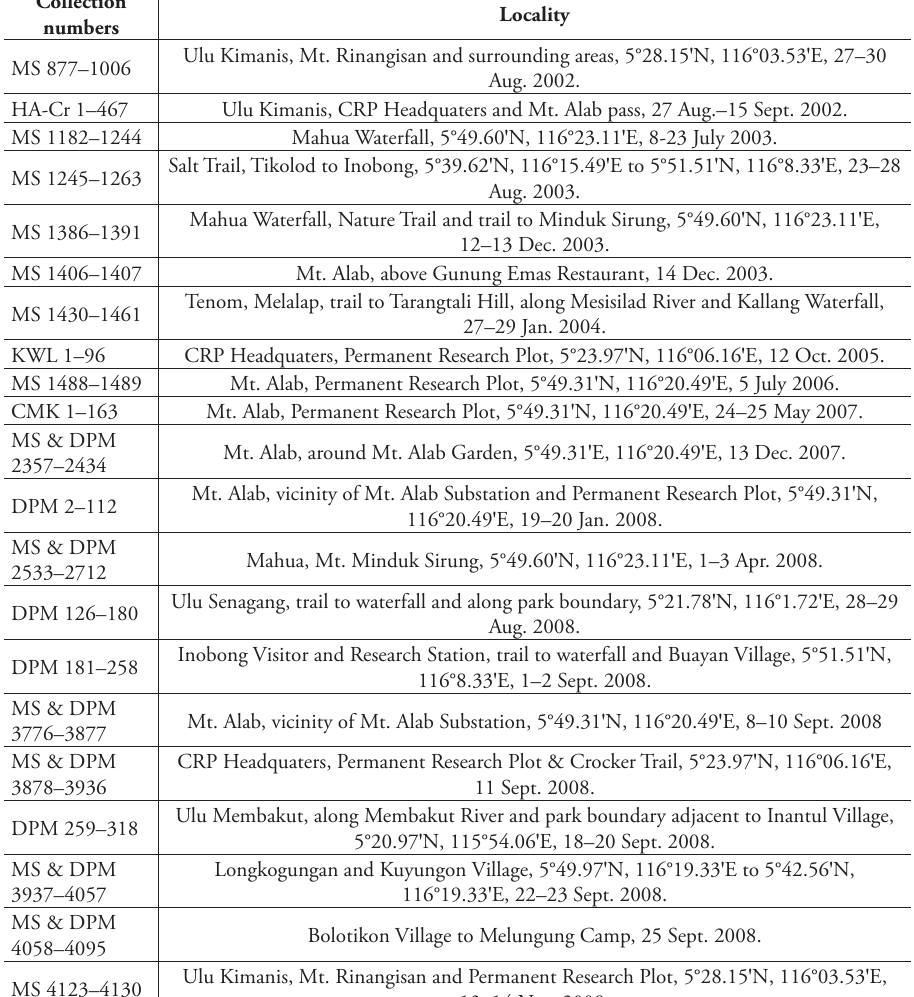
Table 1. Locality and collection details of mosses from Crocker Range Park from the year 2002 to 2008. CMK - Chin Mui Ken; DPM - Dunstan Polus Masundang; HA-Cr - Hiroyuki Akiyama-Crocker; KWL - Kong Wai Ling; MS - Monica